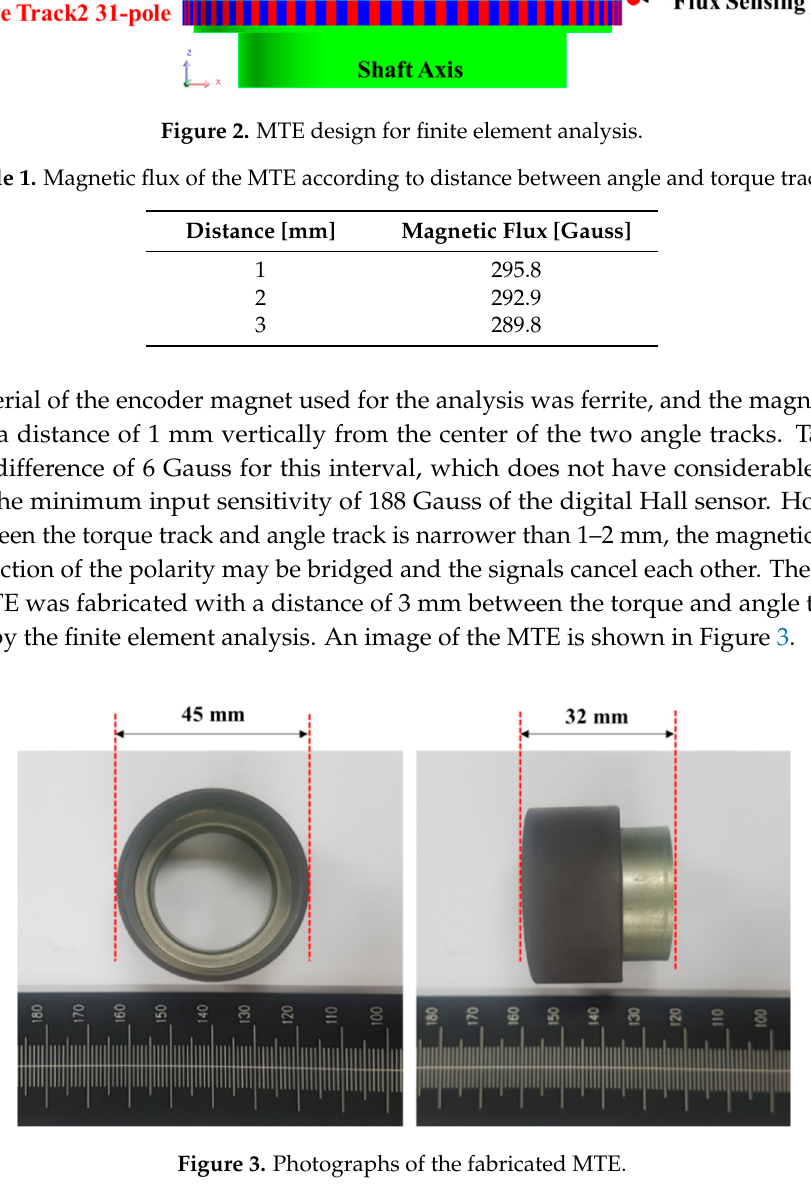
Figure 3. Photographs of the fabricated MTE. Table 1. Magnetic flux of the MTE according to distance between angle and torque tracks.